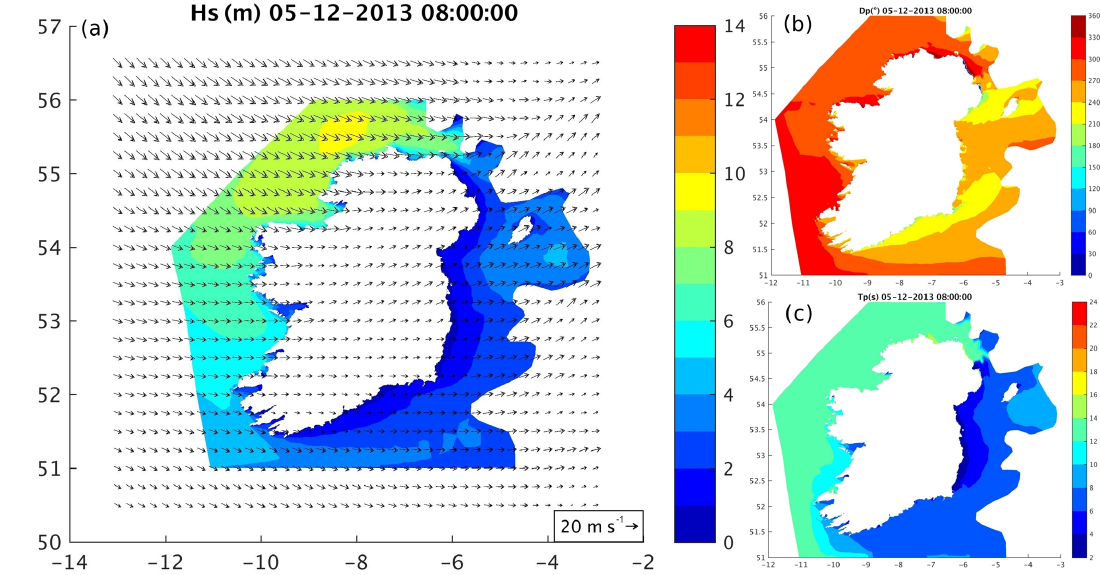
Figure 7. Maps of (a) significant wave height (m) with vectors representing wind speed (ms − 1 ) and direction ( ◦ ), (b) peak wave direction ( ◦ ), and (c) peak wave period (s) at 08:00UTC on 5 December